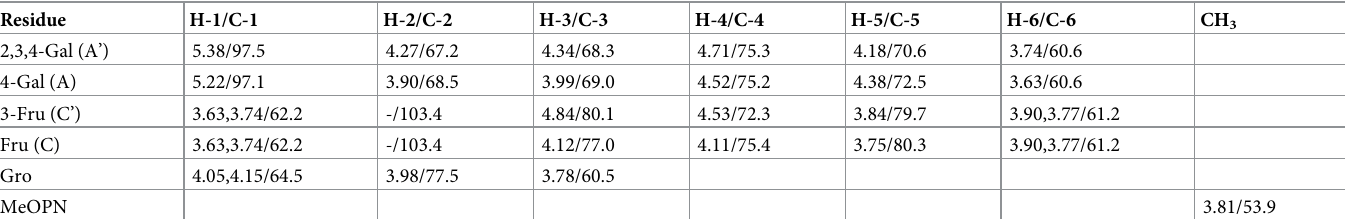
Table 5. 1 H and 13 C NMR chemical shifts of C . jejuni HS1/44 CPS.